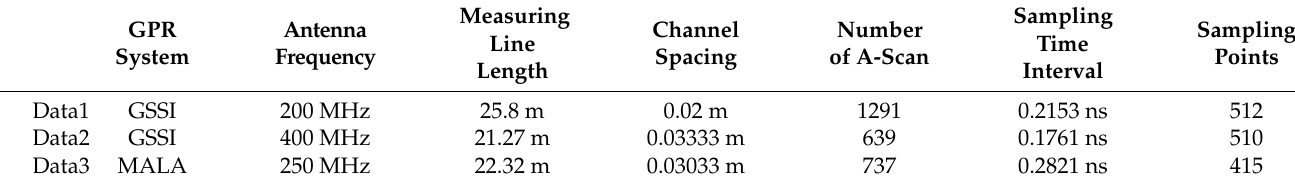
Figure 13. Scene setup of gneiss area. Table 5. Parameters of the measured